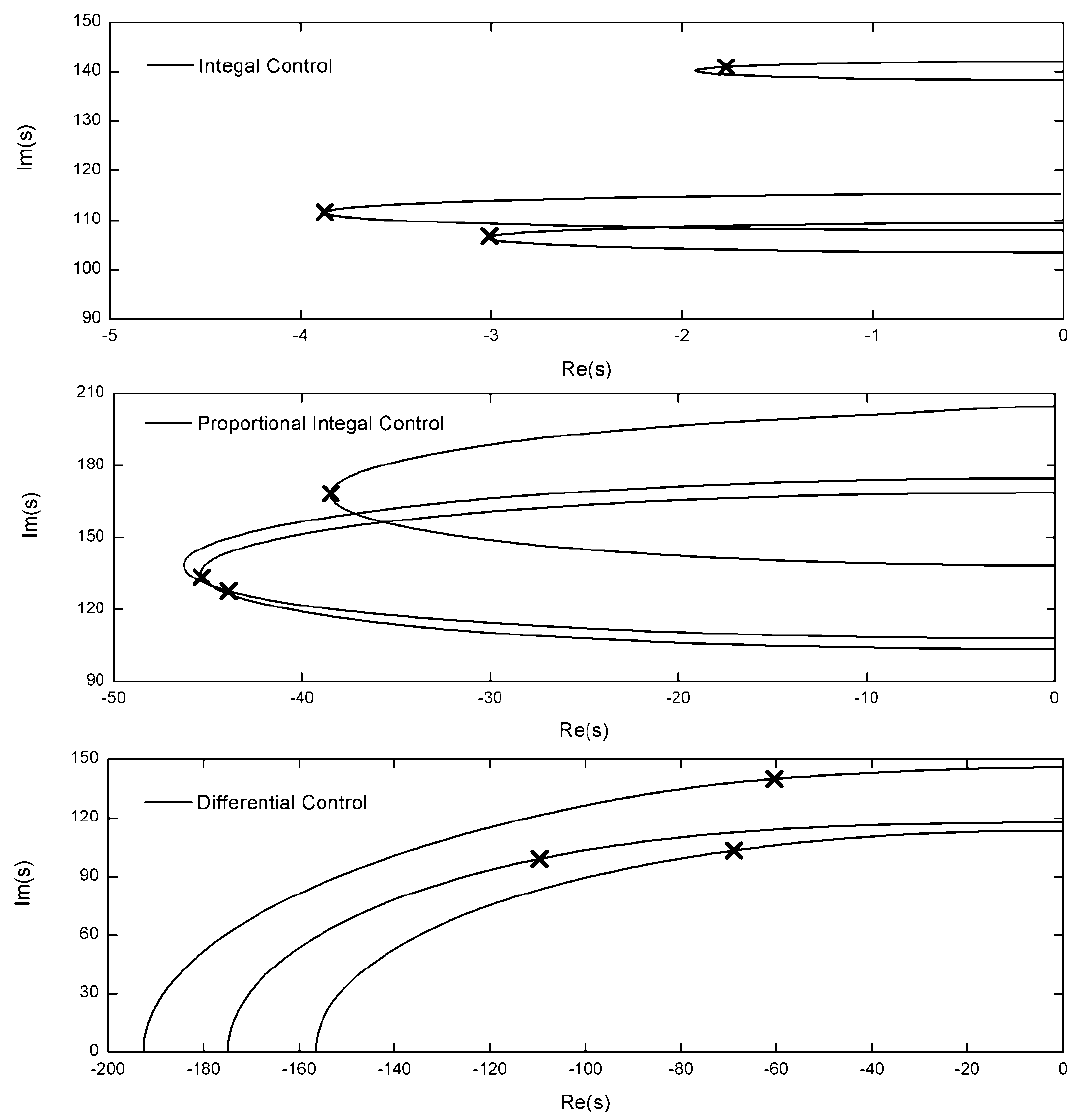
Figure 4. Root locus with three control strategies ( EA = 18,000 N